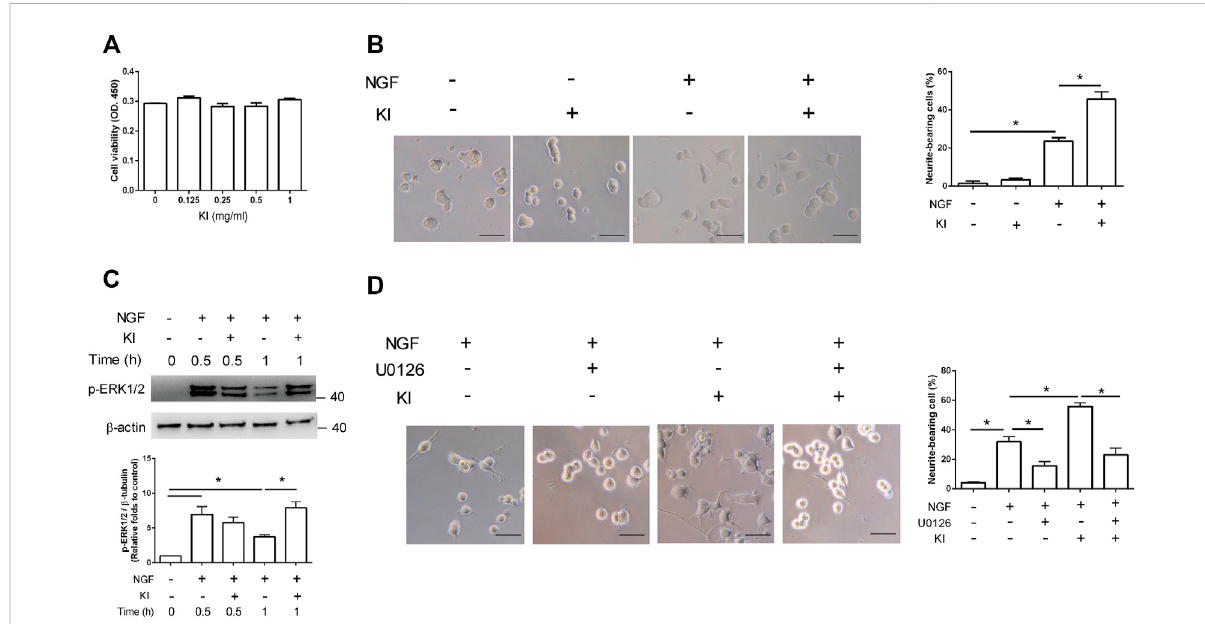
FIGURE 1 PC12 cell neurite growth induction through extracellular signal – regulated kinase (ERK)1/2 phosphorylation after KI Essence extract treatment. (A) KI Essence extract treatmentdid not affect the viability of PC12 cells. PC12 cells were pretreated with low-serum medium for 1 day and then with various concentrations of the KI Essence extract and nerve growth factor (NGF; 50 ng/ml) for 48 h. PC12 cell viability was determined using cell counting kit-8 (CCK-8) assay. (B) Phase-contrast images of cells on day 2 after treatment with NGF in presence or absence of the KI Essence extract (0.25 mg/ml; scale bar: 50 µm). PC12 cells were cotreated with the KI Essence extract and NGF for 2 days, and percentages of neurite- bearing cells on day 2 was assessed. The data are expressed as means ± standard errors of means (SEMs) for ( n = 3; p p < 0.05). (C) PC12 cells treated with 0.25 mg/ml KI Essence extract for various durations (0, 0.5, and 1 h). Phosphorylation levels of ERK (p-ERK) 1/2 and β -tubulin were analyzed throughWesternblotting.Quantitationofp-ERK1/2to β -tubulinispresentedinthebargraph( n =3; p p < 0.05). (D) PC12cellsweretreatedwiththeKI Essenceextract(0.25 mg/ml)andNGFfor2daysinthepresenceorabsenceof10 µMU0126.Phase-contrastimagesofneurite-bearingcellsonday 2are shown (scalebar: 50 µm).The dataare expressedmeans± SEMs( n =3). Quantitation ofpercentageofneurite-bearingcells ispresented inthe bar graph p p <